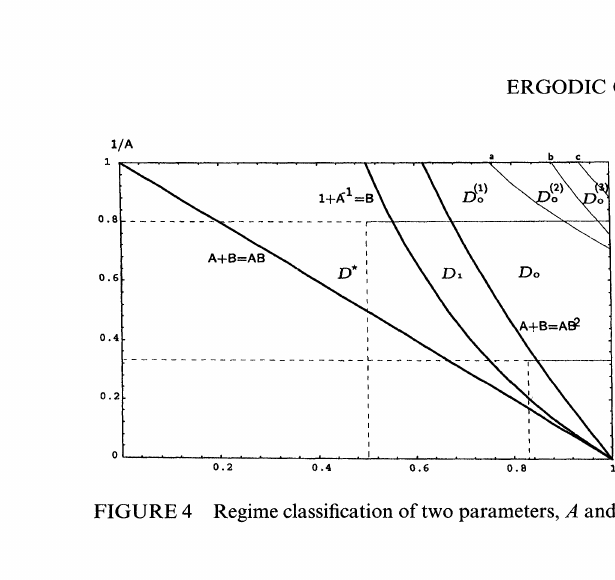
FIGURE 4 Regime classification of two parameters, A and